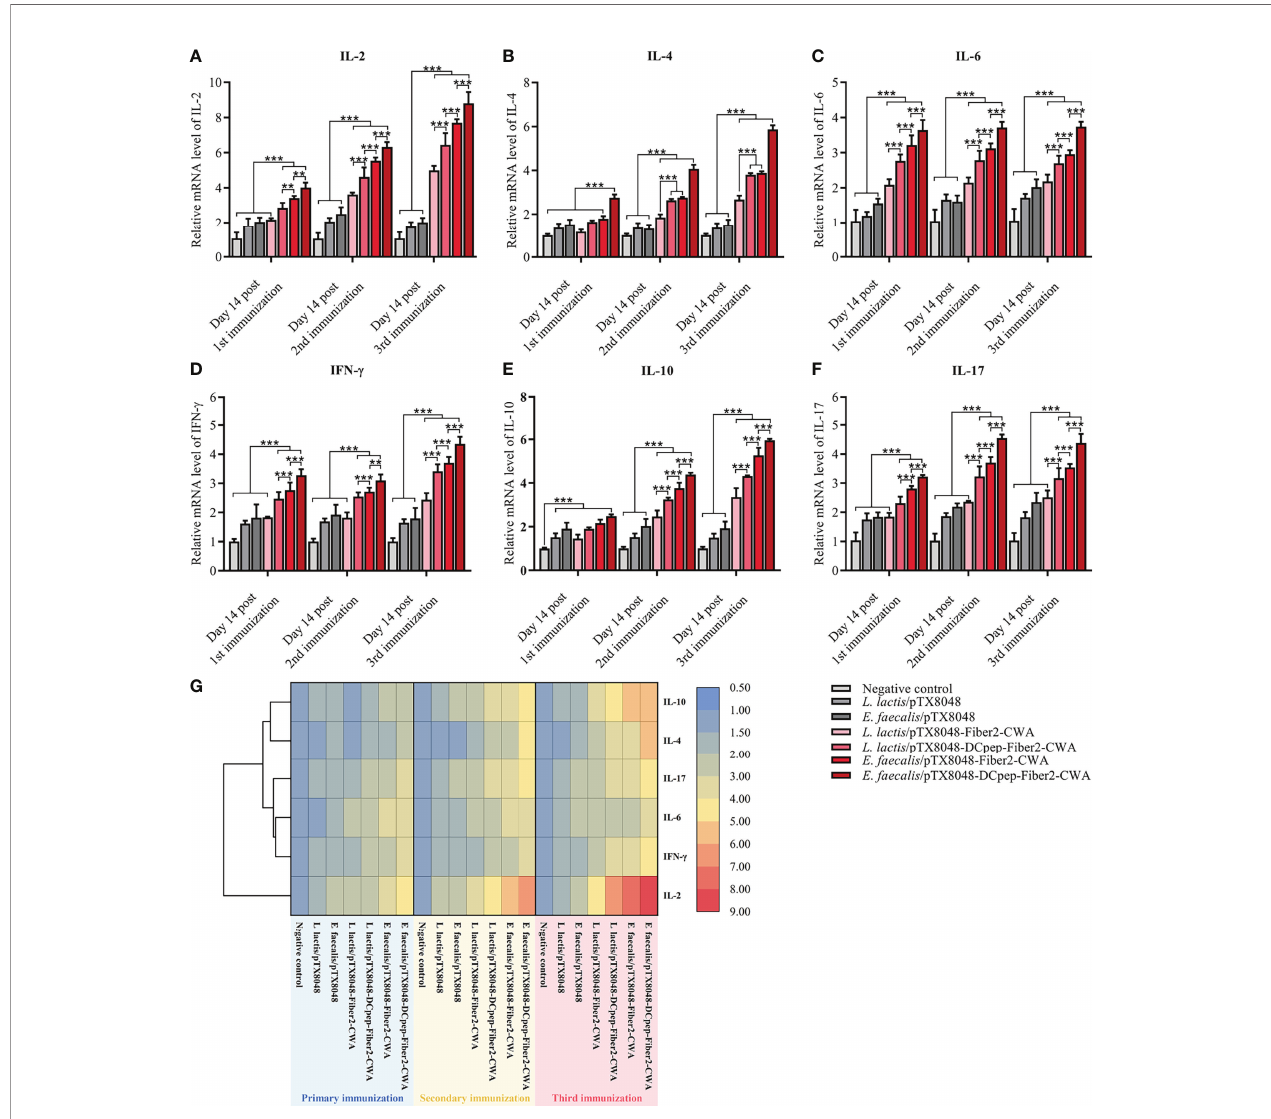
FIGURE 5 | Immune-related cytokine mRNA levels in spleens. The relative mRNA levels of IL-2 (A) , IL-4 (B) , IL-6 (C) , IFN- g (D) , IL-10 (E) , and IL-17A (F) in spleens of chickens (n = 5) in each group were quanti fi ed by real-time PCR and normalized by mRNA levels of reference gene b -actin from the same sample. The values represent mean ± SD. ** p < 0.01, *** p < 0.001. (G) Heat map depicting the cluster analysis of mean values of ChIL-2, ChIL-4, ChIL-6, ChIFN- g , ChIL-10, and ChIL- 17A in spleens after three